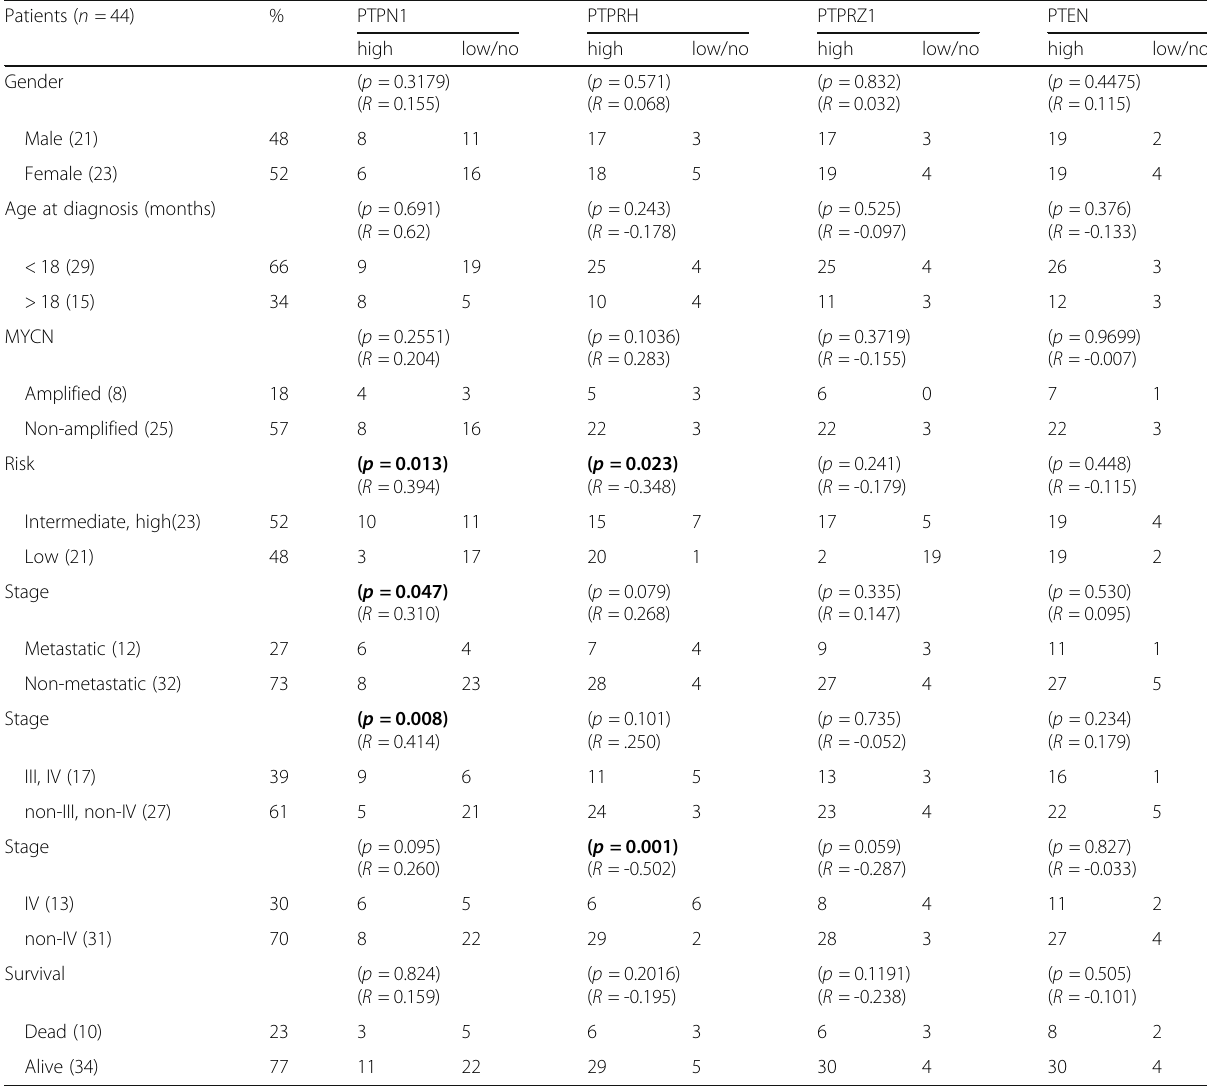
Table 2 Immunostaining of PTPs from NB tissue sections Patients ( n =